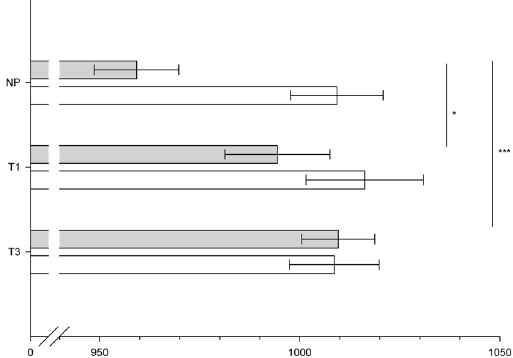
Figure 4. Mean ( ± SEM) P3-2 latencies (ms) in response to anxiety sweat (grey bars) and sport sweat (white bars) deviant stimuli of non-pregnant women (NP), pregnant women in the first (T1), and pregnant women in the third trimester (T3), * p ≤ 0.05, *** p ≤